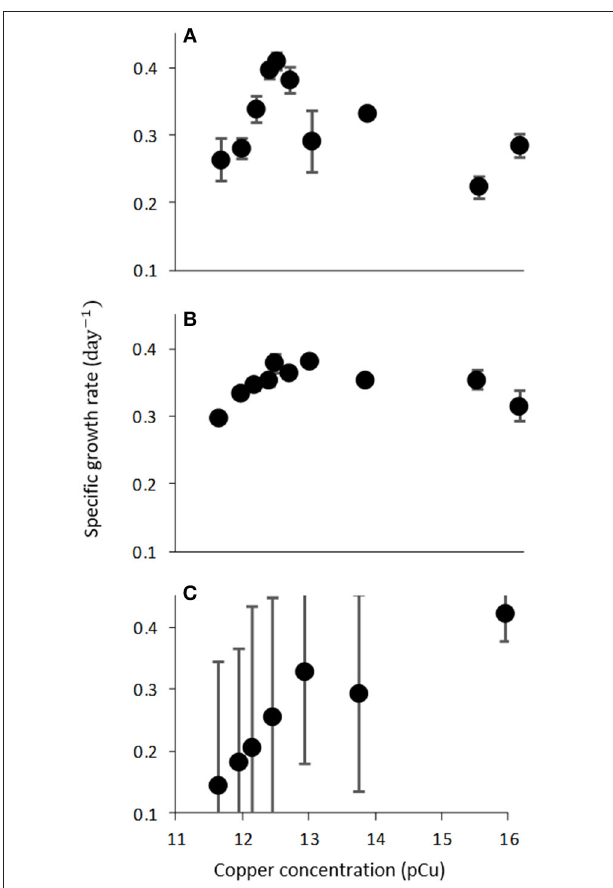
FIGURE 3 | Growth rate (d − 1 ) of C. watsonii WH0003 as function of increasing pCu when grown with varied nitrogen sources; (A) 376 µ M NaNO 3 , (B) 50 µ M NH 4 Cl, and (C) N 2 -fixation. Points represent averages of triplicate treatments ± standard error.